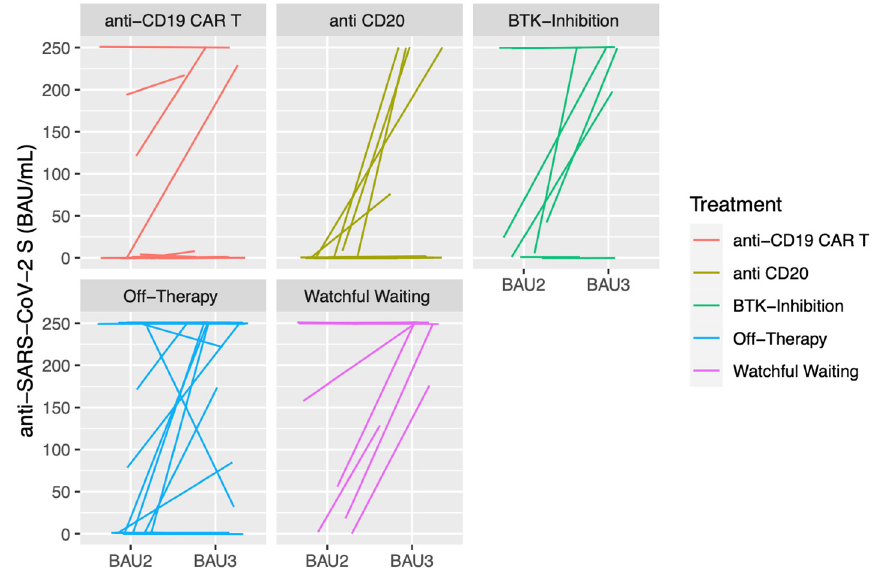
Figure 5. Antibody kinetics of the maximal anti-SARS-CoV-2 S antibody levels in BAU/mL after the 2nd (BAU2) and 3rd (BAU3) vaccinations by treatment modality.